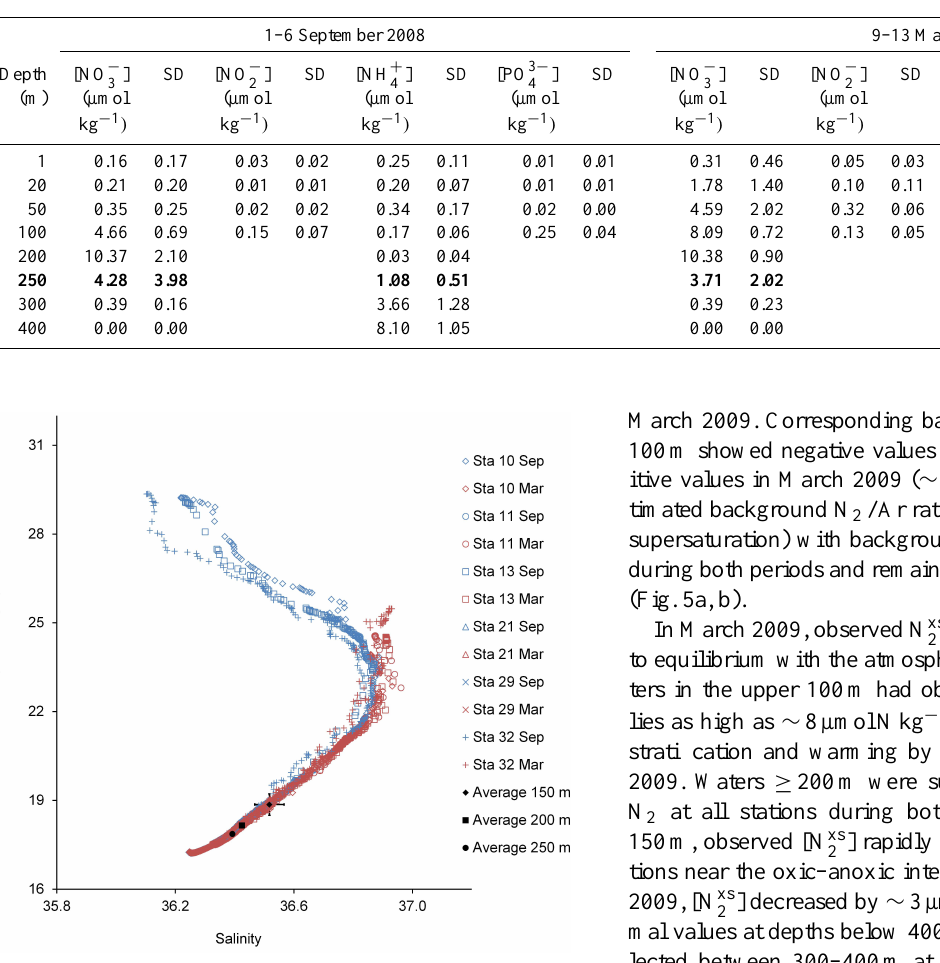
determinations during September 2008 and March 2009 in the 2